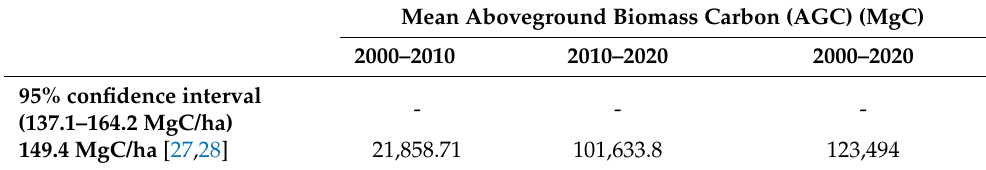
Table 6. Summary of carbon equivalent lost to the atmosphere through forest cover loss.